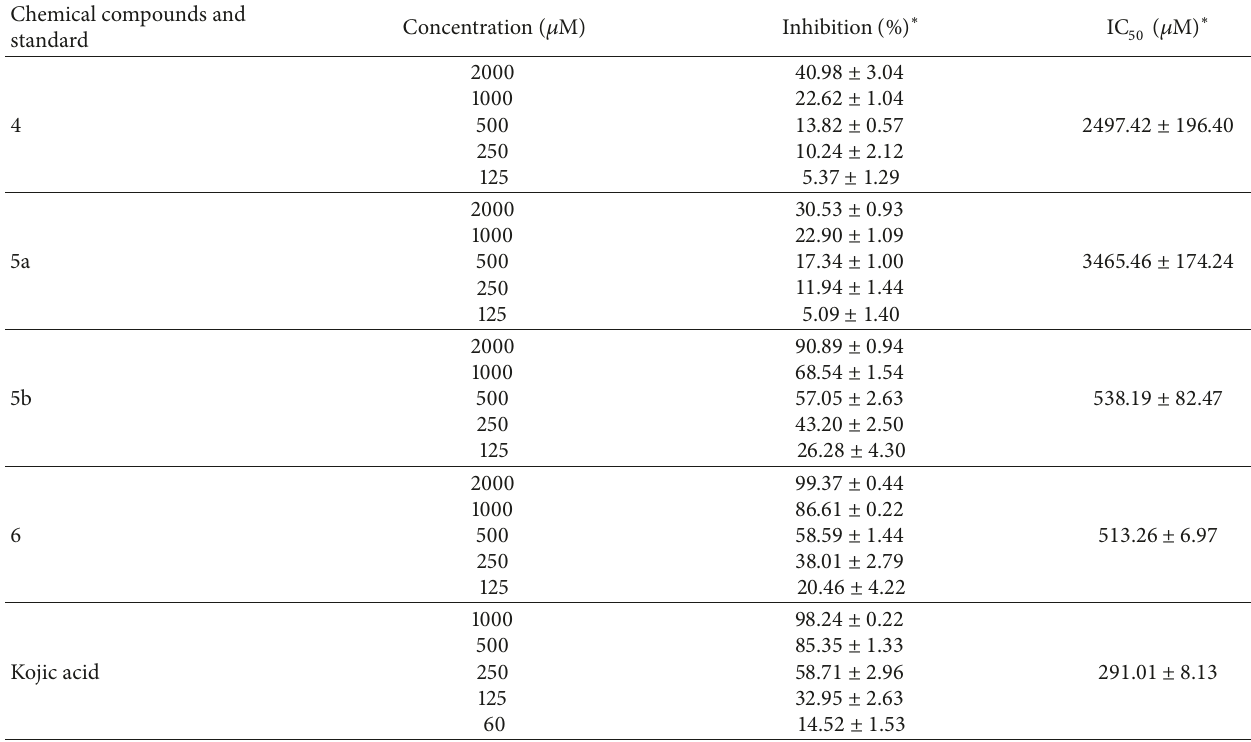
Table 2: The tyrosinase inhibitory activity of different concentrations of S-substituted perhalonitrobuta-1,3-diene compounds. Chemical compounds and